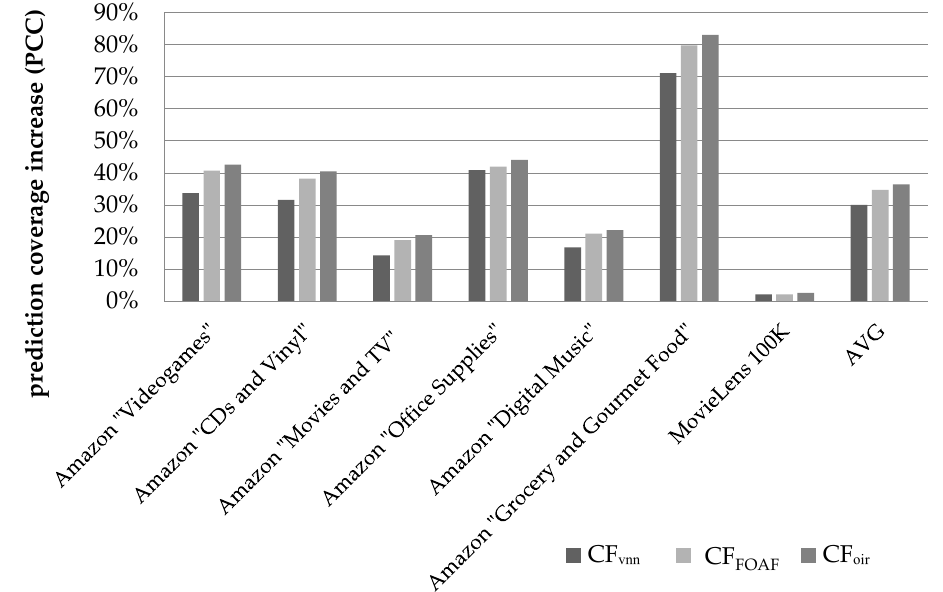
Figure 6. Coverage increase for the datasets summarized in Table 4, when the PCC user similarity metric is used.